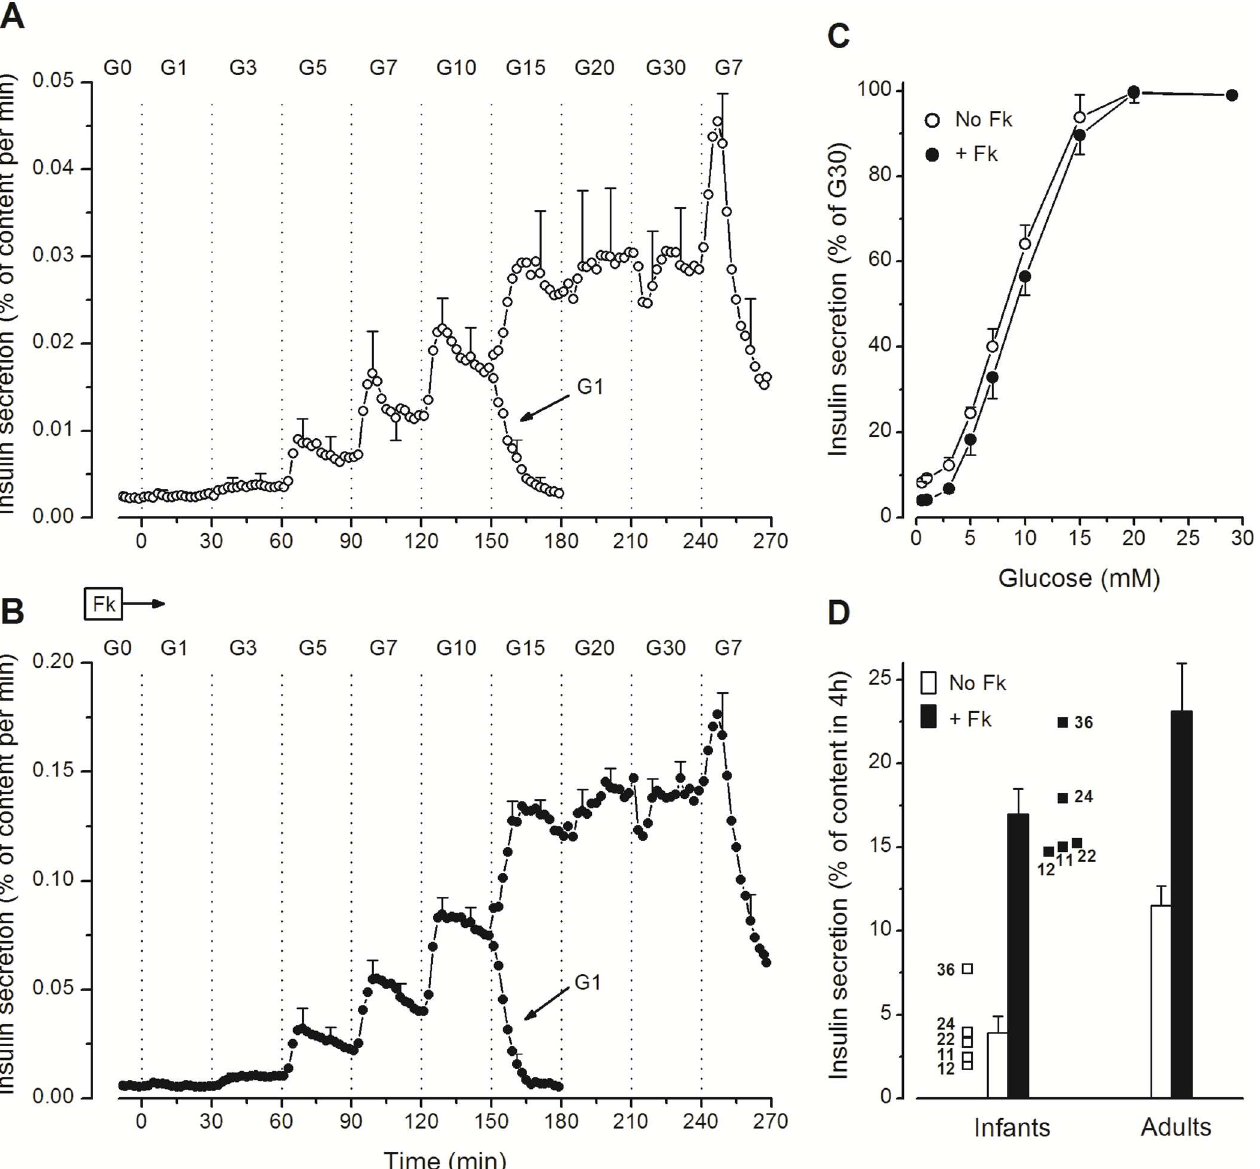
Fig 1. Concentration-dependency of glucose-induced insulin secretion in perifused islets from human infants. (A and B) The concentration of glucose (G in mmol/l) was increasedand decreasedas indicated, but the islets were not exposed to the whole range of concentrations. One group of islets was perifused in G0 for 60 min before the glucose concentration was increasedstepwise to G10 and eventuallydecreasedto G1 at 150 min. Another group from the same preparation was perifused in G7 for 60 min before the glucose concentration was increasedstepwise to G30 and eventually decreased to G7. Insulin secretion rates in G7 and G10 from the two series, run in parallel,were similar and therefore averaged to obtain the full dose curve for each of the five islet preparations. Parallel experiments were done in the absence (A) or presence (B) of 1 μ mol/l forskolin (Fk) in islets from the five infants. (C) Concentration-dependency curves expressed as percentagesof insulin secretion rates in G30. Values are means ± SE for the five infant cases. (D) Total insulinsecretion (without and with forskolin) was calculated between 0 and 240 min and is shown for each of the five infant cases identifiedby their age in months. Columns show means ± SE for the five infant cases and for previously reported results with 8 preparations of adult islets [33]. (Fig 1C), with a threshold at G3-G4, half-maximal stimulation between G7 and G10, and maximum stimulation slightly above G15.